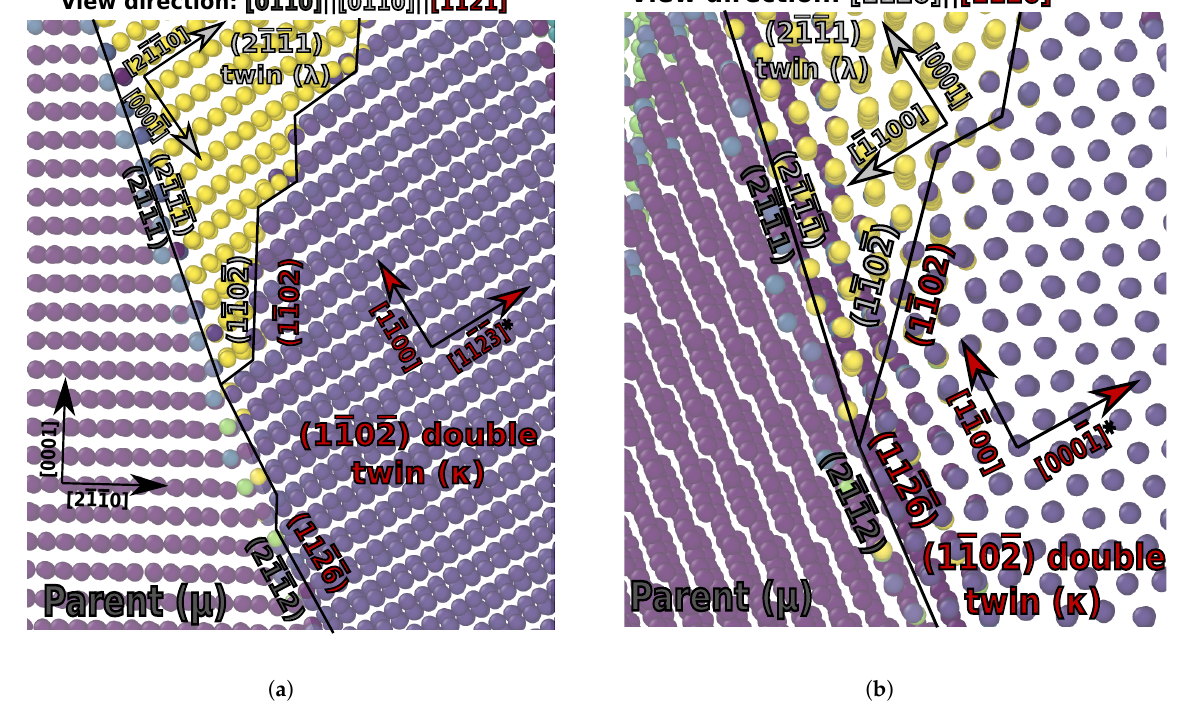
Figure 9. ( 1102 ) twin within ( 2111 ) twin. ( a ) The ( 1102 ) twin boundary is on the twin plane with two-layer twinning disconnections visible from the [ 0110 ] λ view direction. ( b ) A second point of view is displayed to aid in three-dimensional